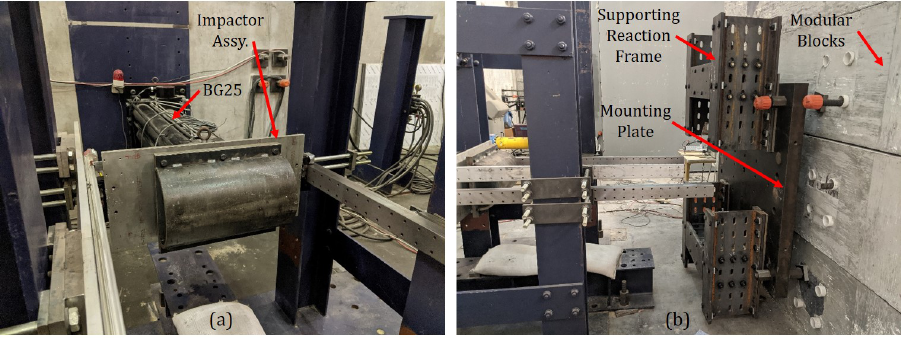
Figure 2. Testing System: ( a ) Impact components—alternate view, ( b ) Reaction components—clamping assemblies not